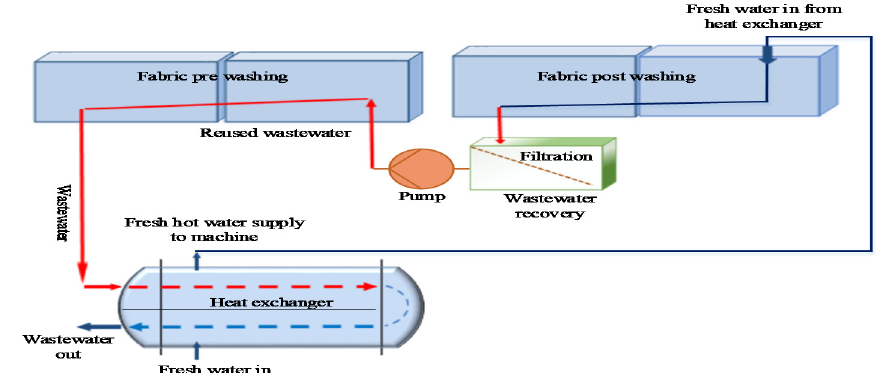
Fig. 1: Water recycling and on-site water reuse at the wet-processing machine with water heat exchanger